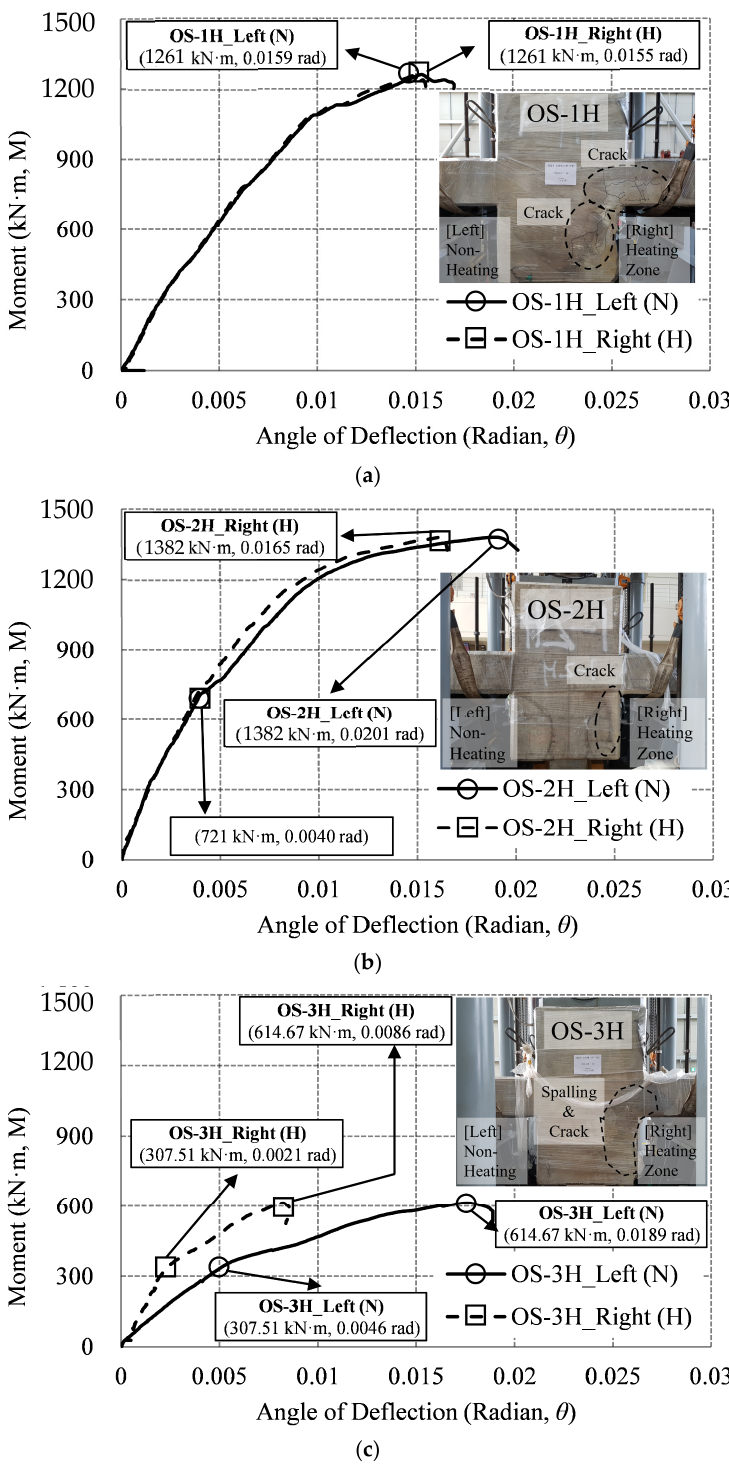
Figure 17. Moment–deflection angle relationship (OS specimen): ( a ) 1 h (OS-1H); ( b ) 2 h (OS-2H); ( c ) 3 h (OS-3H).